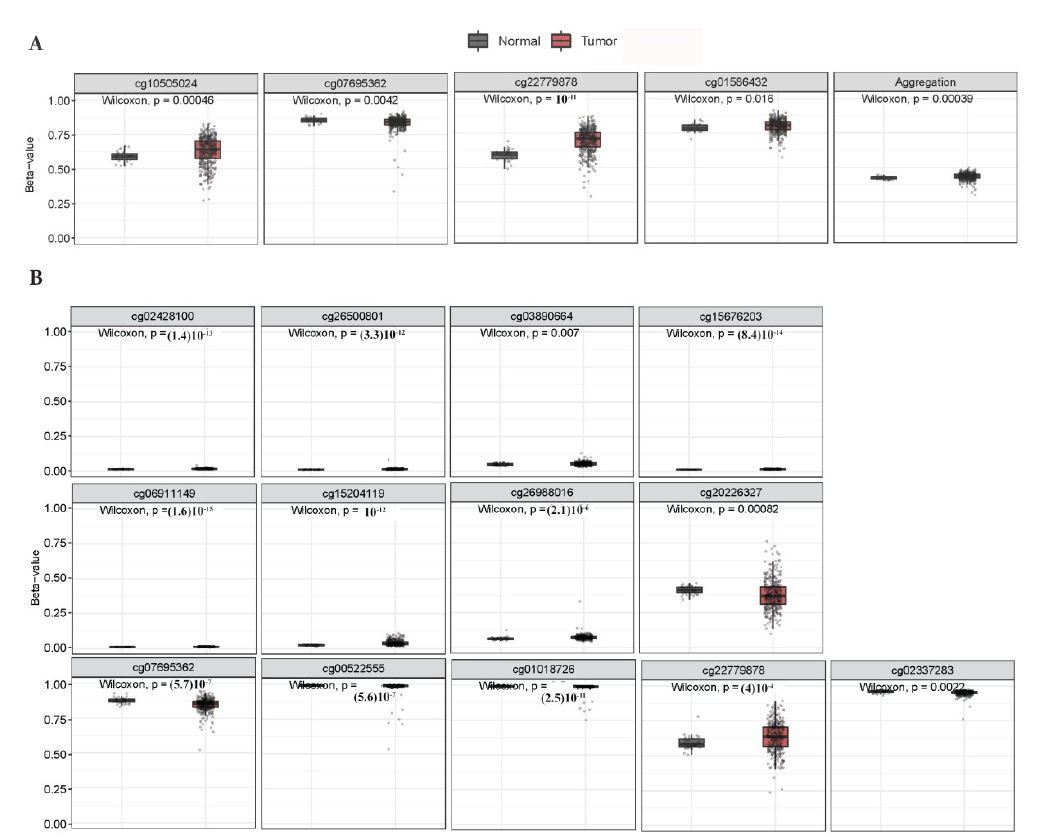
Figure 3. Box plots of di ff erentially methylated KEAP1 CpGs between all-stages cohort ( A : LUAD, B : LUSC) and control.